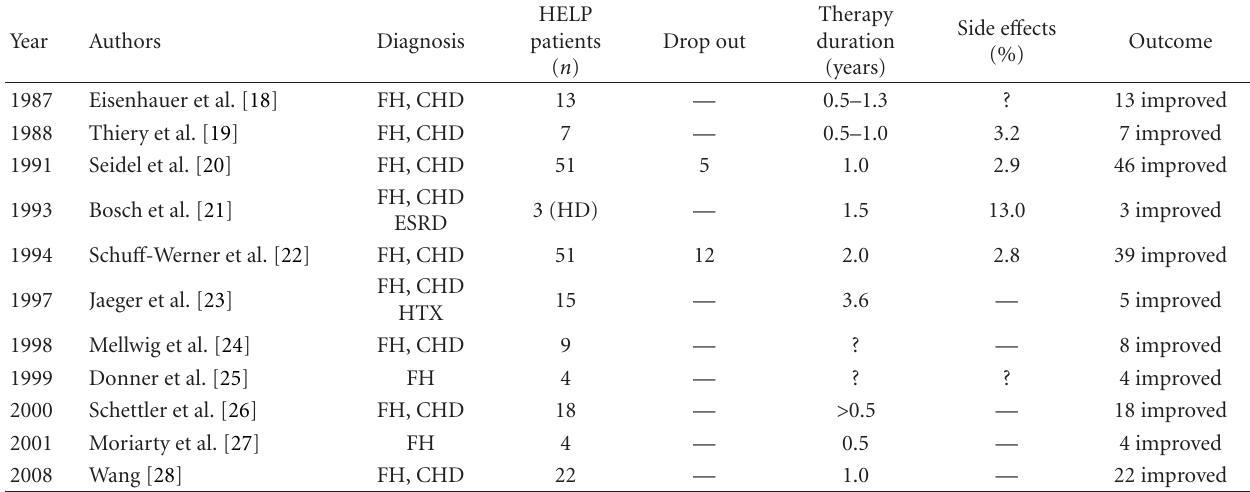
Table 5: Clinical results with the HELP-LDL apheresis system (B. Braun, Germany) (literature overview). Year